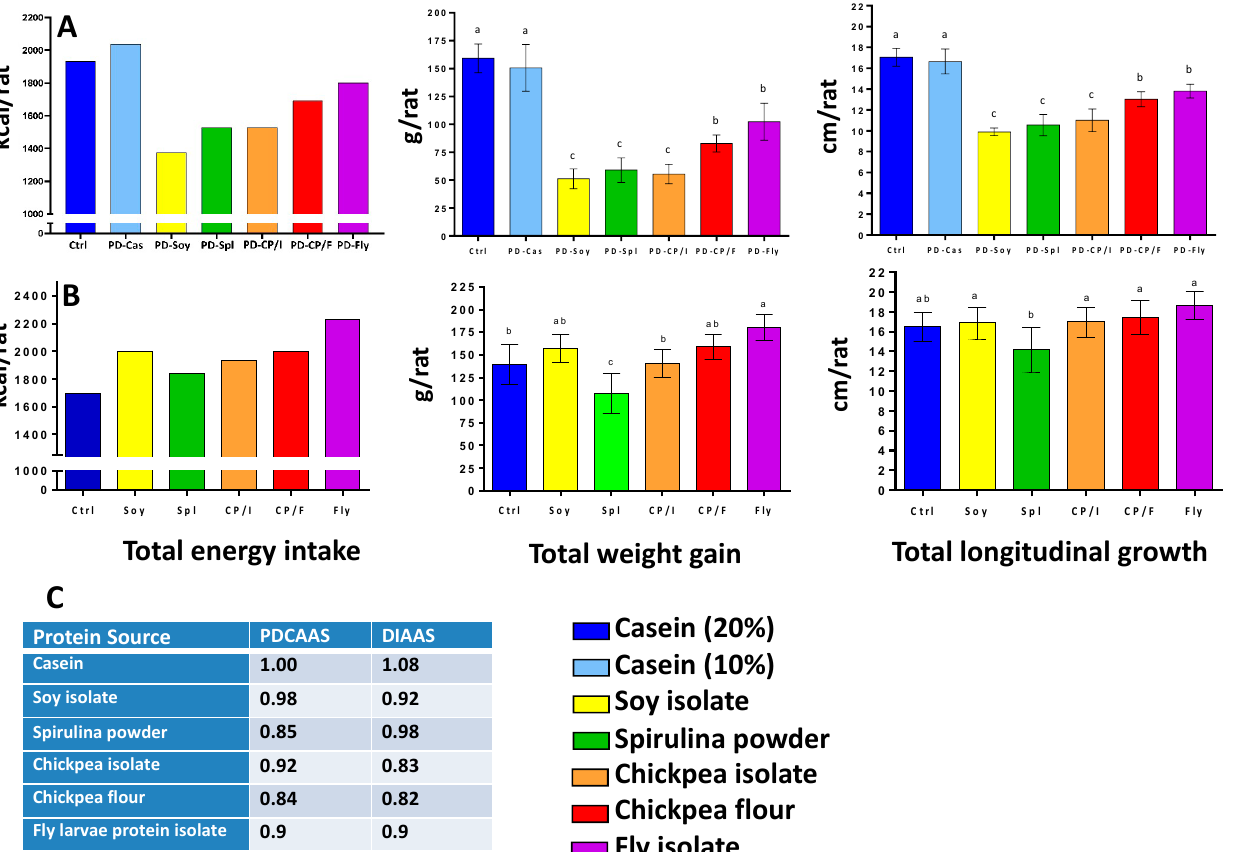
Figure 1. Energy Consumption and Growth Patterns. Total energy intake, weight gain, and longitudinal growth of rats in the 6-week experimental period. Comparison of diets with 10% protein ( A ); Comparison of diets with 20% protein ( B ); Published PDCASS and DIASS parameters for these proteins [10–14] ( C ). Abbreviations: Ctrl—20% casein; PD-Cas—10% casein; Soy—20% soy isolate;